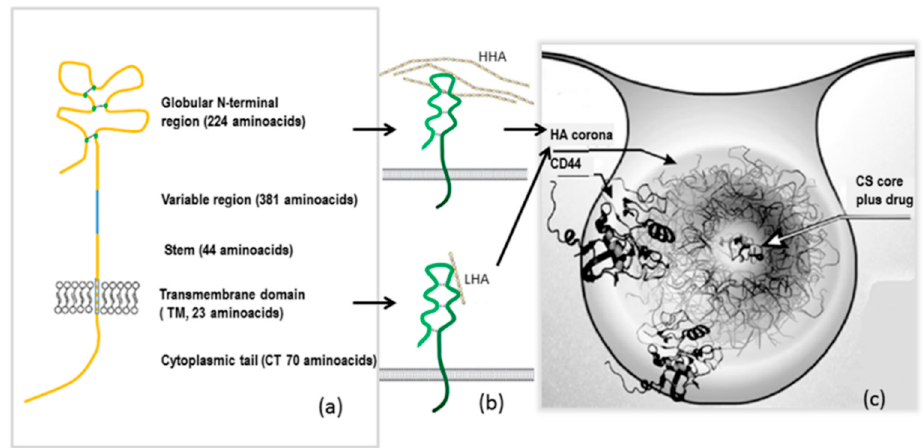
Figure 4. ( a ) CD44 structure; ( b ) CD44–HA interaction with high molecular weight HA (HMw